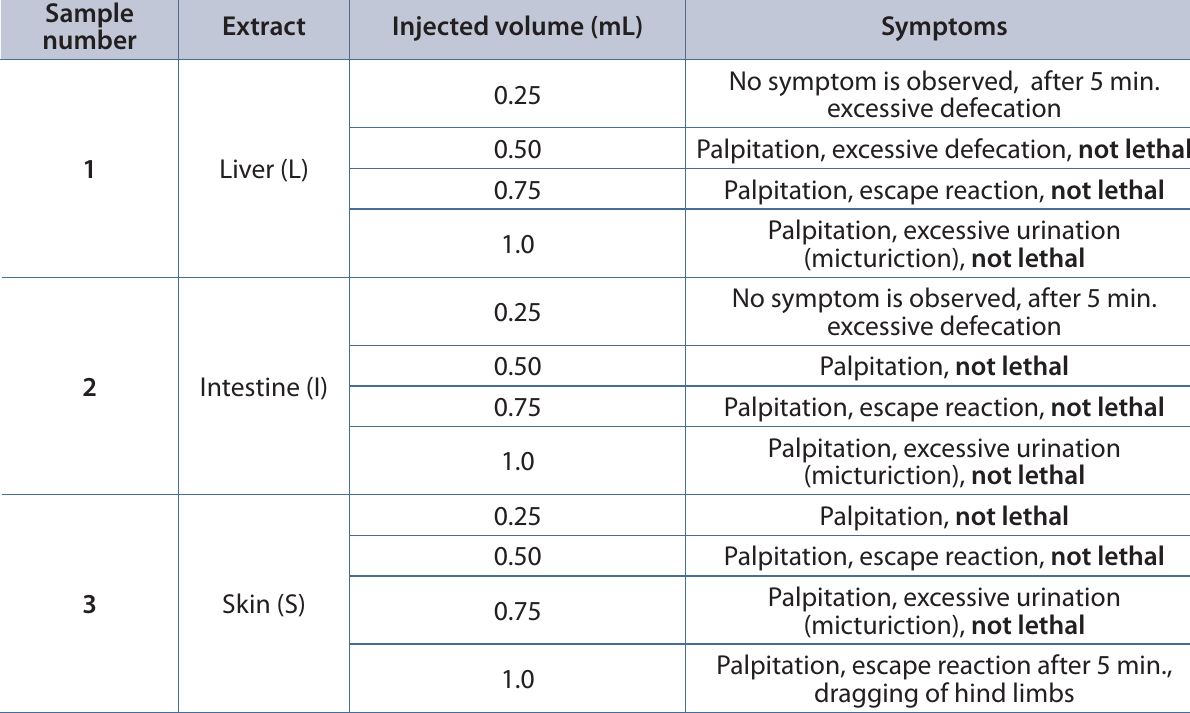
Table 1. Toxicity of various pufferfish samples at 5.0 mg/mL intraperitoneally injected into male albino mice (20 g ±